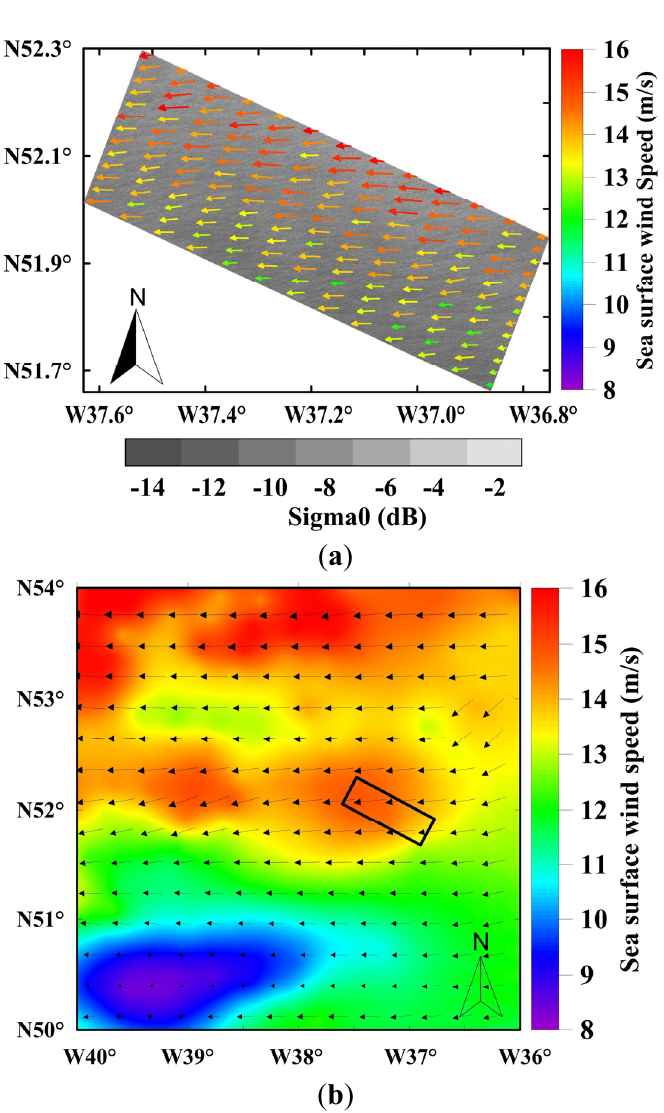
Figure 10. The application of the SIRX-MOD model to X-SAR data. ( a ) Sea surface wind field retrieved using the SIRX-MOD model with X-SAR data acquired on October 6, 1994 at 12:42 GMT over the Atlantic Ocean; ( b ) Sea surface wind field from ERS-1/SCAT obtained on October 6, 1994 at 13:27 GMT over the Atlantic Ocean. The black rectangle indicates the area where the X-SAR scene was